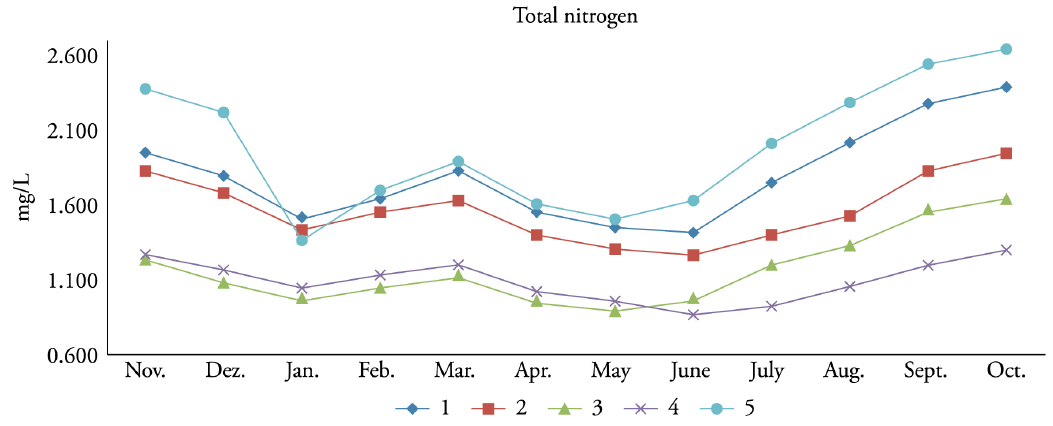
Figure 2. Total Nitrogen among the